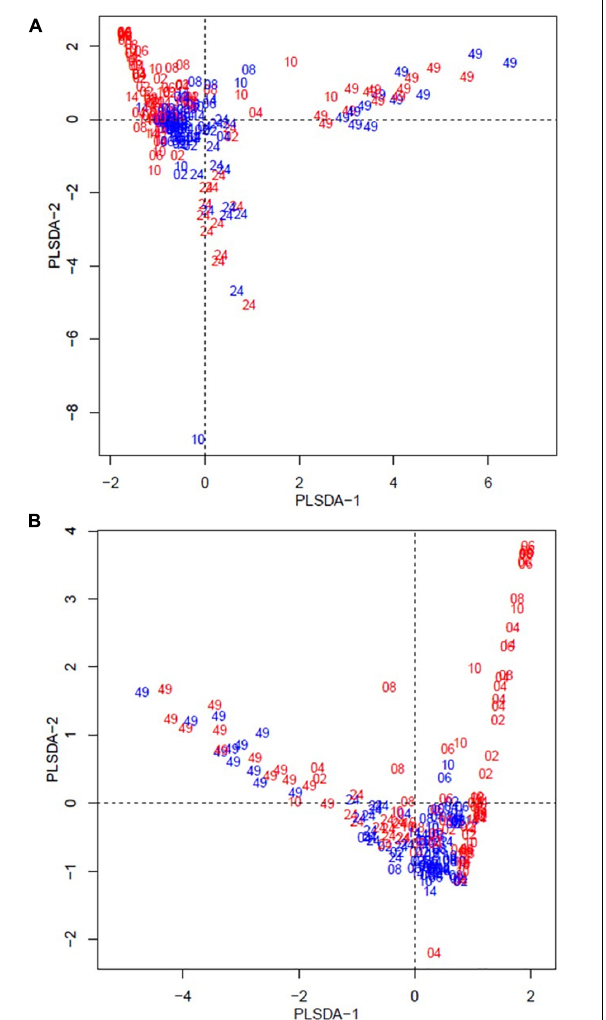
FIGURE 3 | Partial least square discriminant analysis (PLSDA) of the bacteria community at the genus level in treatment (red) and control (blue) dietary treatment across sampling periods. Calves during the rearing time were fed as follows: milk twice a day and ad libitum control and treatment concentrates at weeks 2 and 4; milk once a day and ad libitum control and treatment concentrates and partial mixed diet (PMR) diet at weeks 6, 8, and 10; concentrates step-down weaned and PMR diets fed ad libitum until week 14; and grazing a mixed sward of ryegrass/clover as one mob at weeks 24 and 49. Sampling times were from 2 to 49 weeks. (A) PLSDA of the bacteria community – 245 bacterial genera. (B) PLSDA of the abundant ( = 0.5 %) bacteria – 41 abundant bacterial genera. Calves from the treated and control groups are represented in red and blue, respectively. The numbers correspond to the sampling time in weeks.